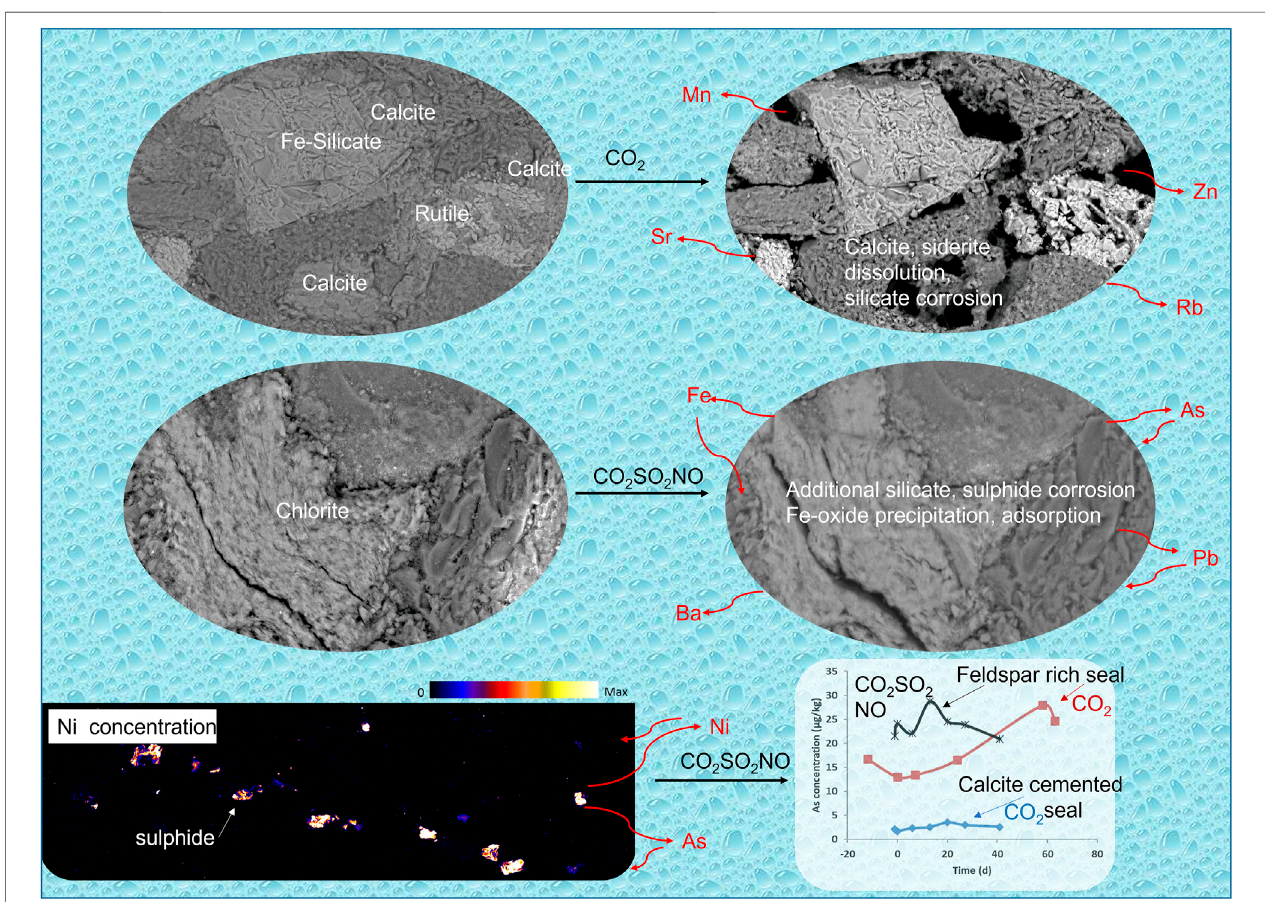
FIGURE 10 | Schematic indicating the key mineral reactions and the associated metal release to water or metal release and subsequent precipitation.